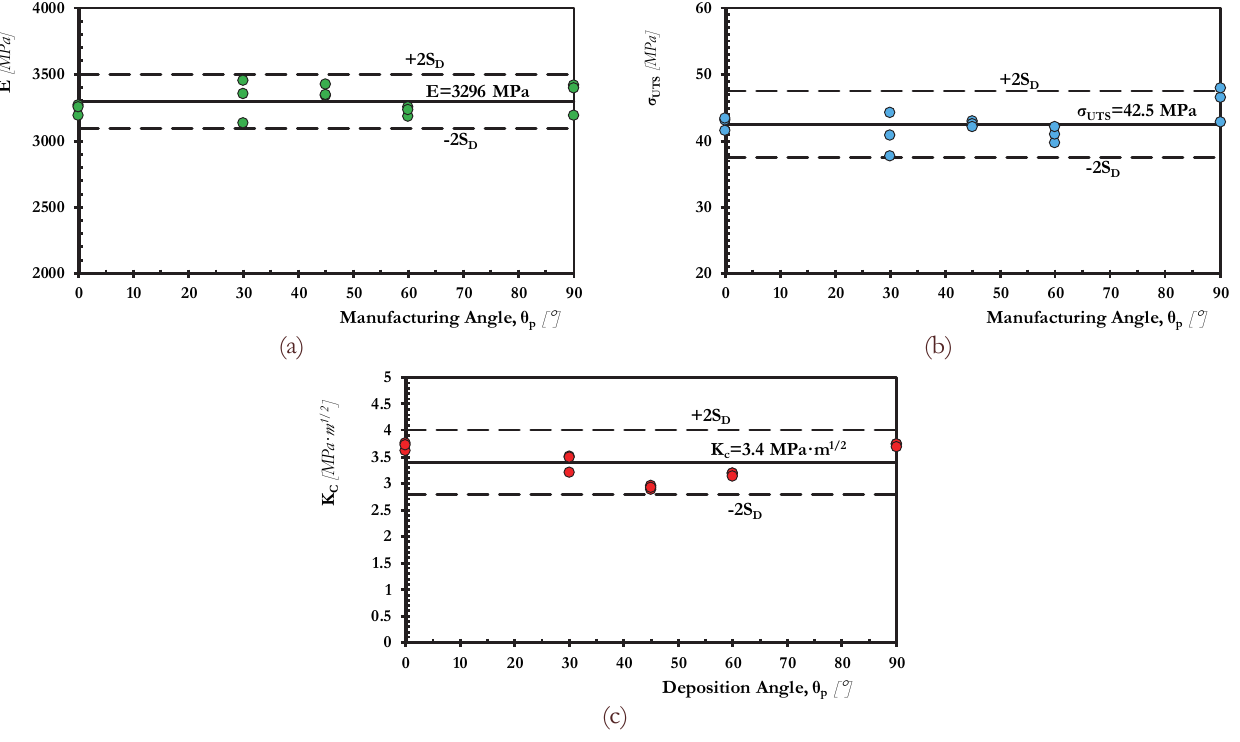
Figure 4: Influence of manufacturing angle θ p on E (a), σ UTS (b), and K C